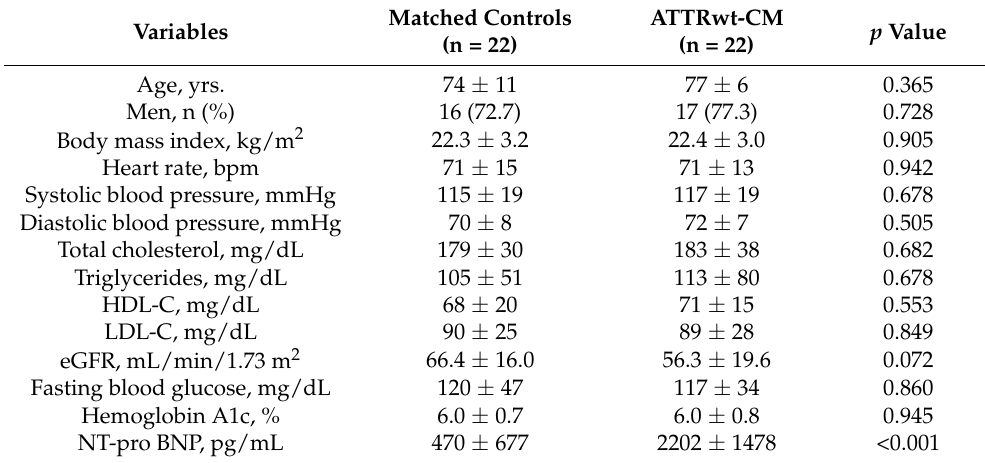
Table 1. Clinical Characteristics of One-by-one Matched Controls and Patients with